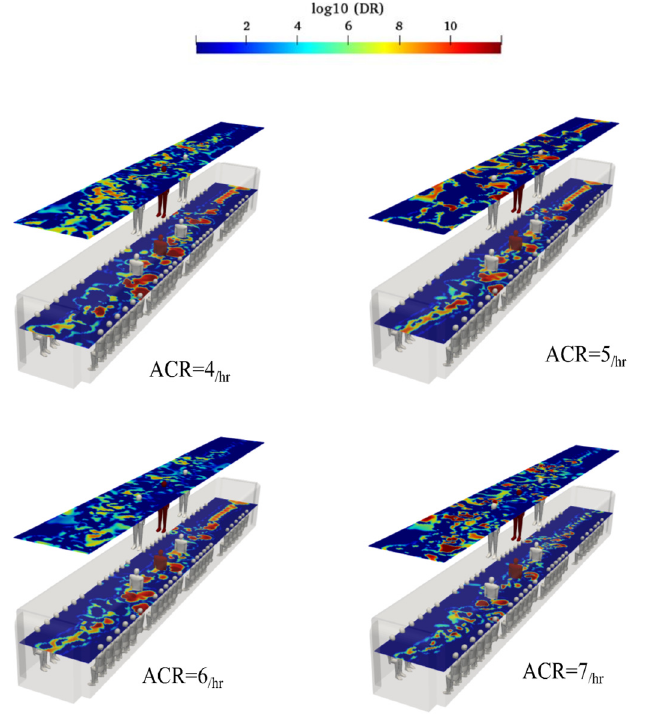
Figure 18. Evolution of the counters of log 10 (DR) when the infected individual was standing near the supply air ducts of the conventional HVAC systems (Case 3) at the time of 180 s for various poorly ventilated air change rates.